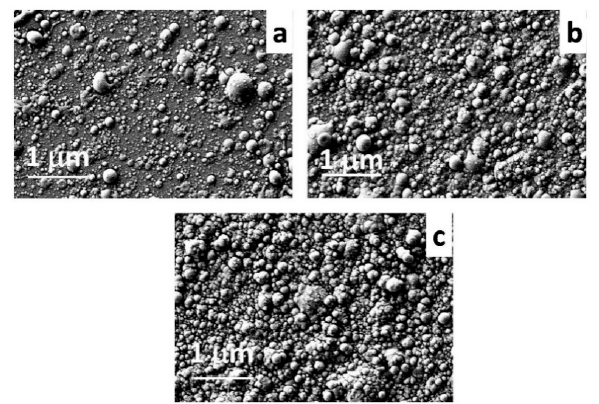
Figure 6. FESEM micrographs of films deposited at different substrate temperatures from a target with a Cr-B molar ratio of 1:4; ( a ) film deposited at 25 °C; ( b ) film deposited at 300 °C; ( c ) film deposited at 500 °C.